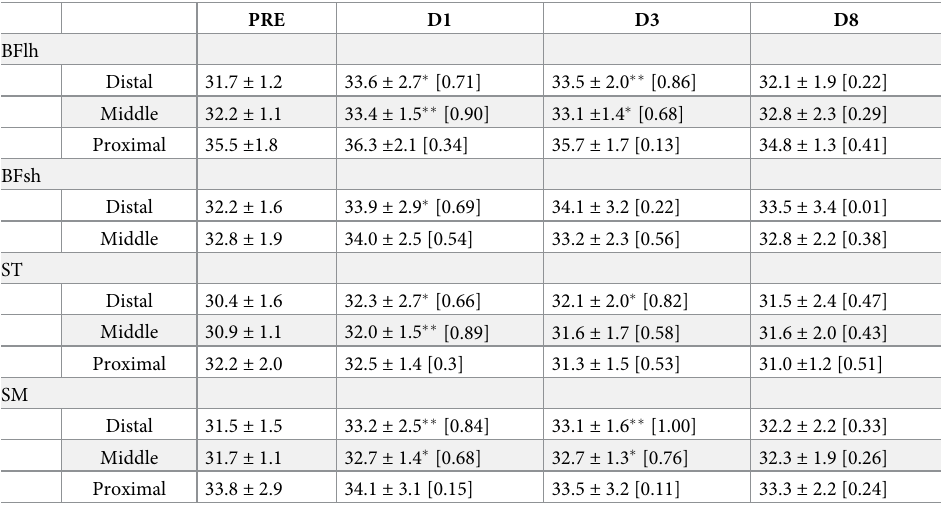
Table 2. Time-dependent change in the absolute value of T 2 values (Mean ± SD) measured before (PRE) and 1 day (D1), 3 days (D3) and 8 days (D8) after the marathon race. Effect sizes are shown in